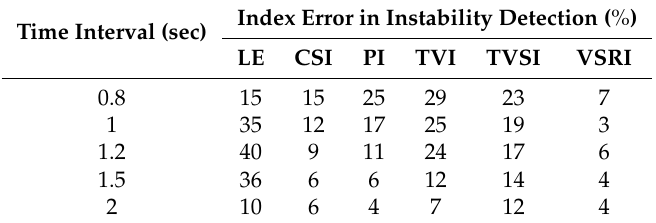
Table 1. SVS indices performance in instability detection.